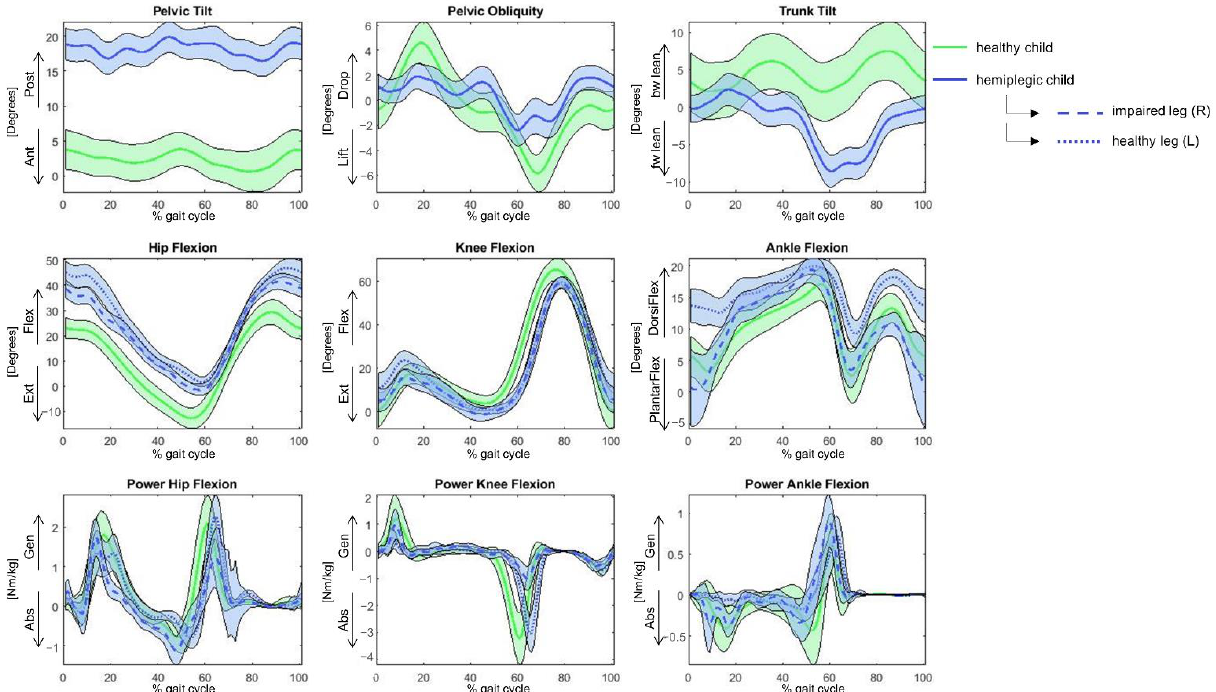
Figure 6. First and second lines show kinematic data, while the third line shows kinetics data of HC (green) and CP01 (blue). Dashed blue line represents the hemiparetic side; dotted blue line is related to the healthy side. The lines are the mean value for each joint over the total number of steps recorded. The colored area represents the standard deviation.